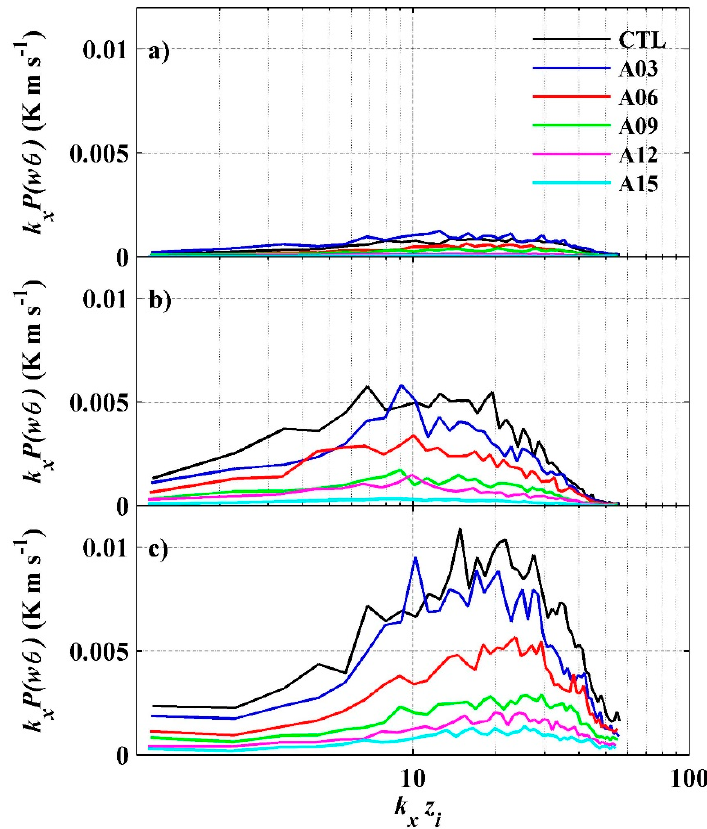
Figure 7. Heat flux ( w - θ ) cospectra for the case with different AOD values and the free-atmosphere potential temperature gradient of 6 K km − 1 . The cospectra at the top ( a ), middle ( b ), and bottom ( c ) correspond to the heights z / z i = 0.9, 0.5, and 0.1, respectively. The color scheme for cases with different AOD is the same as in Figure 6.